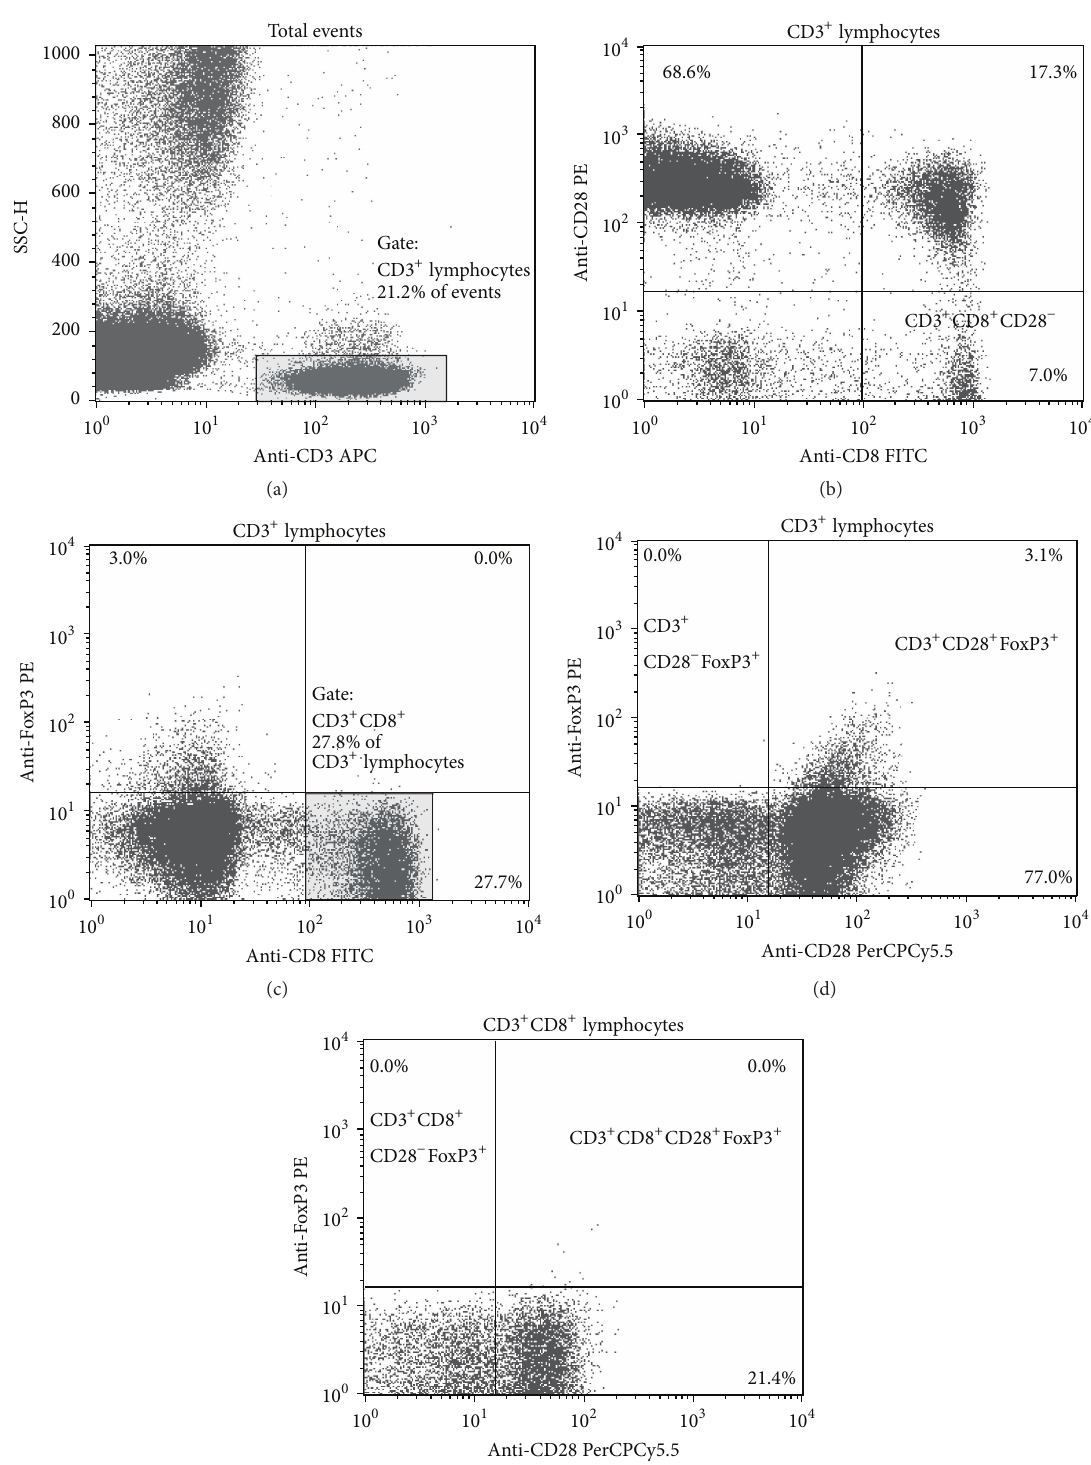
Figure 1: Flow cytometry analysis of CD 3 + CD 8 + CD 28 − and CD 3 + CD 8 + CD 28 − Foxp 3 + subpopulations. Gating strategy: (a) SSC versus anti-CD3 APC fluorescence plot. CD 3 + lymphocytes are shown in the gate. (b) Anti-CD28 PE versus anti-CD8 FITC fluorescence plot. CD 3 + CD 8 + CD 28 − cells are shown in lower right part of the chart. (c) Anti-FoxP3 PE versus anti-CD8 FITC fluorescence plot. CD 3 + CD 8 + cells are shown in the gate. (d) Anti-FoxP3 PE versus anti-CD28 PerCPCy5.5 fluorescence plot. Foxp3 expression is present on non-CD 8 + cells in upper right part of the chart. (e) Anti-FoxP3 PE versus anti-CD28 PerCPCy5.5 fluorescence plot. Lack of Foxp3 expression is shown on CD 3 + CD 8 + CD 28 − cells in upper left part of the